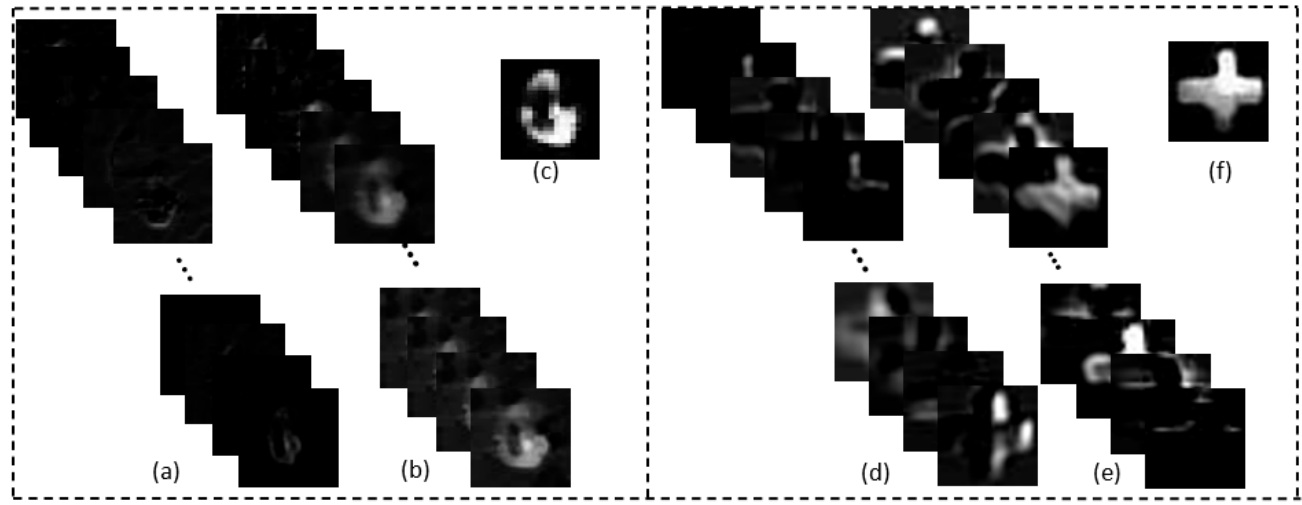
Figure 10. The results of each layer of convolution: ( a , d ) part of the first 64 feature maps, ( b , e ) part of the second layer of 32 feature maps, and ( c,f ) part of the 1-feature map of the third layer.